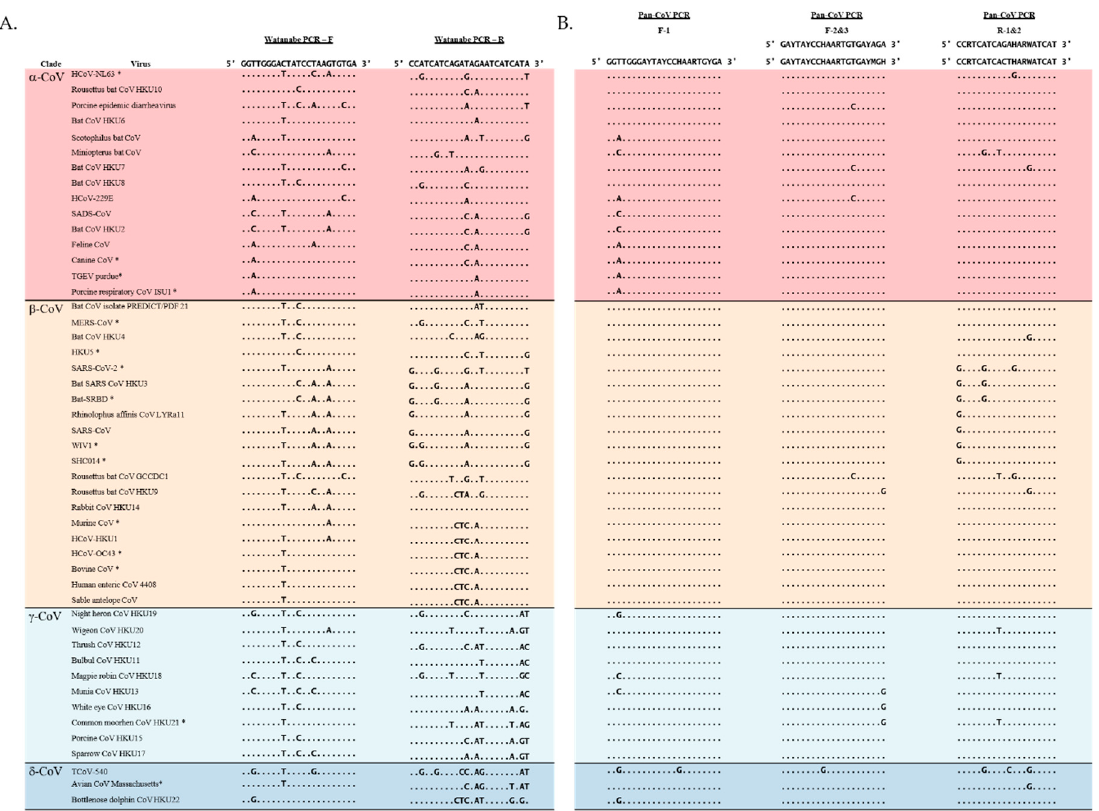
Figure 1. Primer aligned with 48 CoV sequences that represent all four genera of CoVs. Representatives for each group were chosen randomly and include all tested CoVs. ( A ) Watanabe and ( B ) Pan-CoV primers aligned with CoV representatives. Red: α -CoVs, yellow: β − CoVs, light blue: δ -CoVs, dark blue: γ -CoVs. * = in-house tested CoVs.